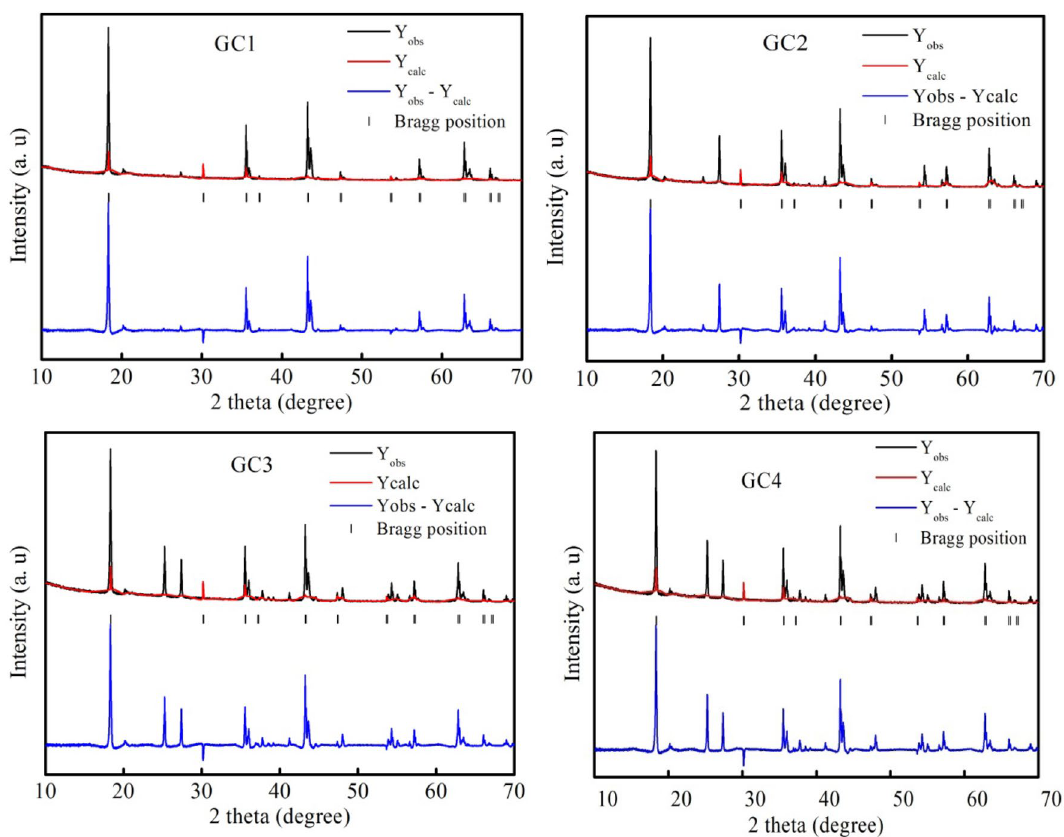
Fig. 3 Reitveld refined XRD spectrum of the prepared LTO material of a GC1 b GC2 c GC3 d GC4